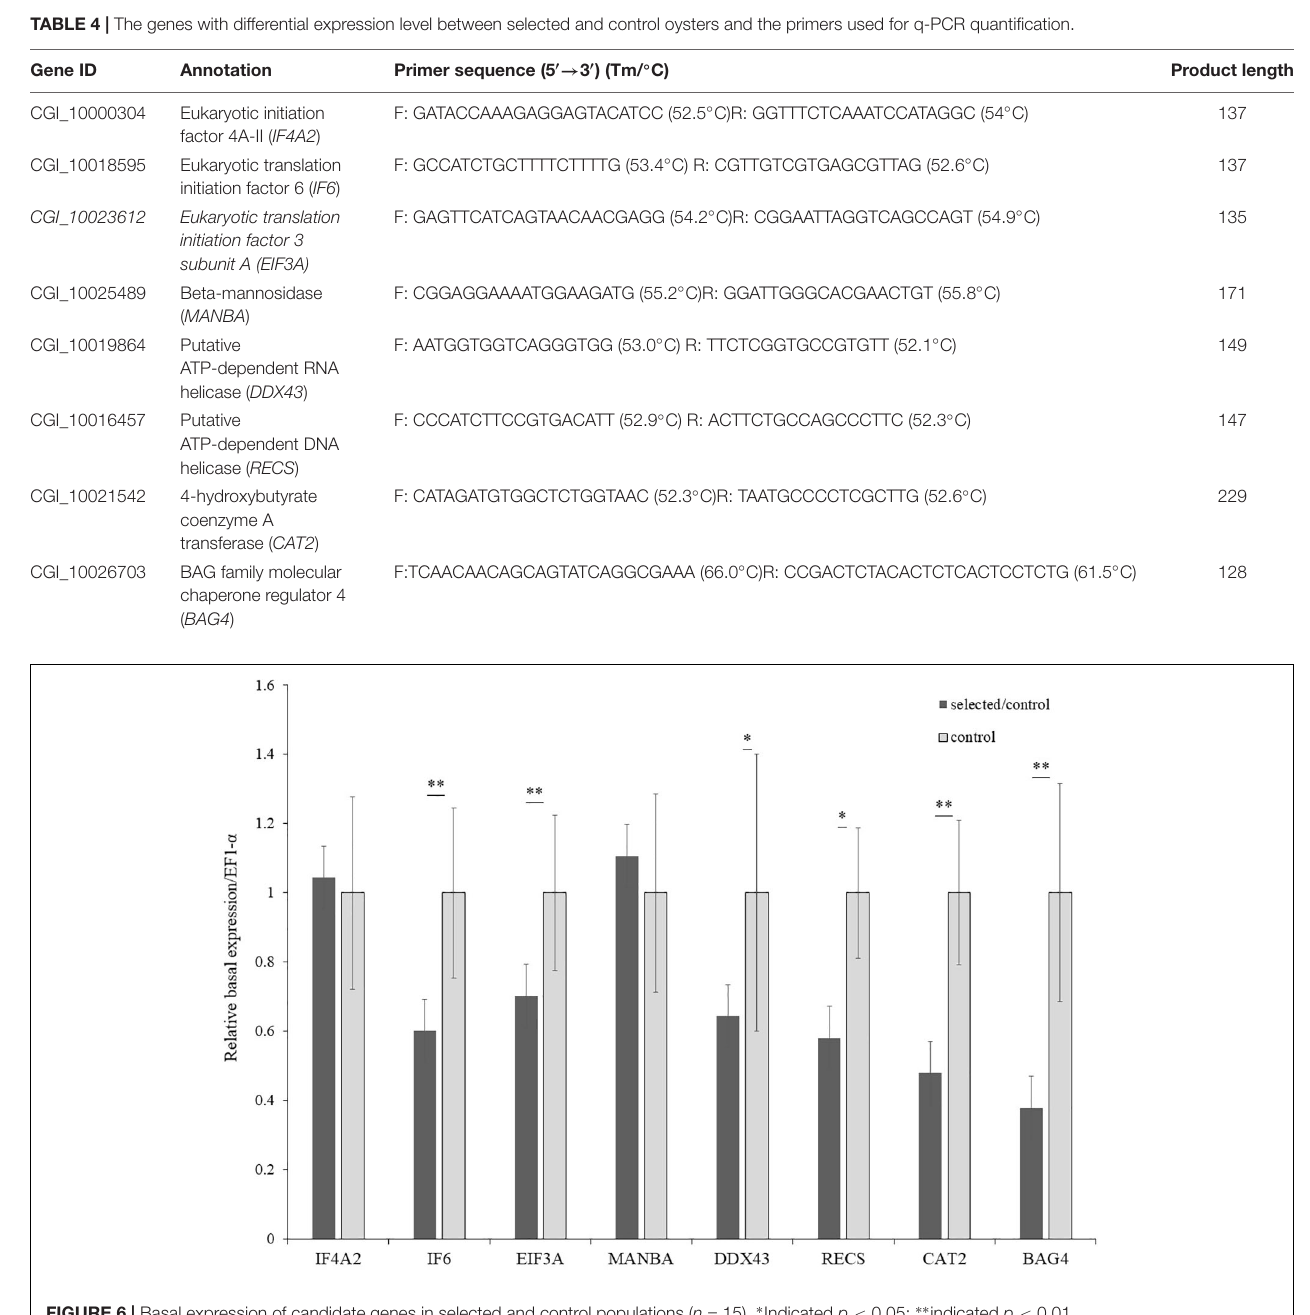
FIGURE 6 | Basal expression of candidate genes in selected and control populations ( n = 15). ∗ Indicated p < 0.05; ∗∗ indicated p <